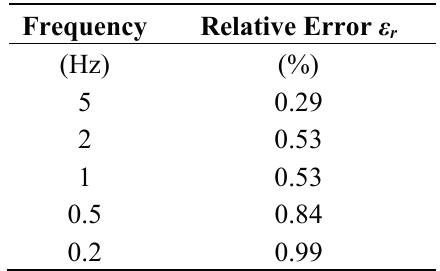
Table 4. Relative error of MEMS accelerometer.